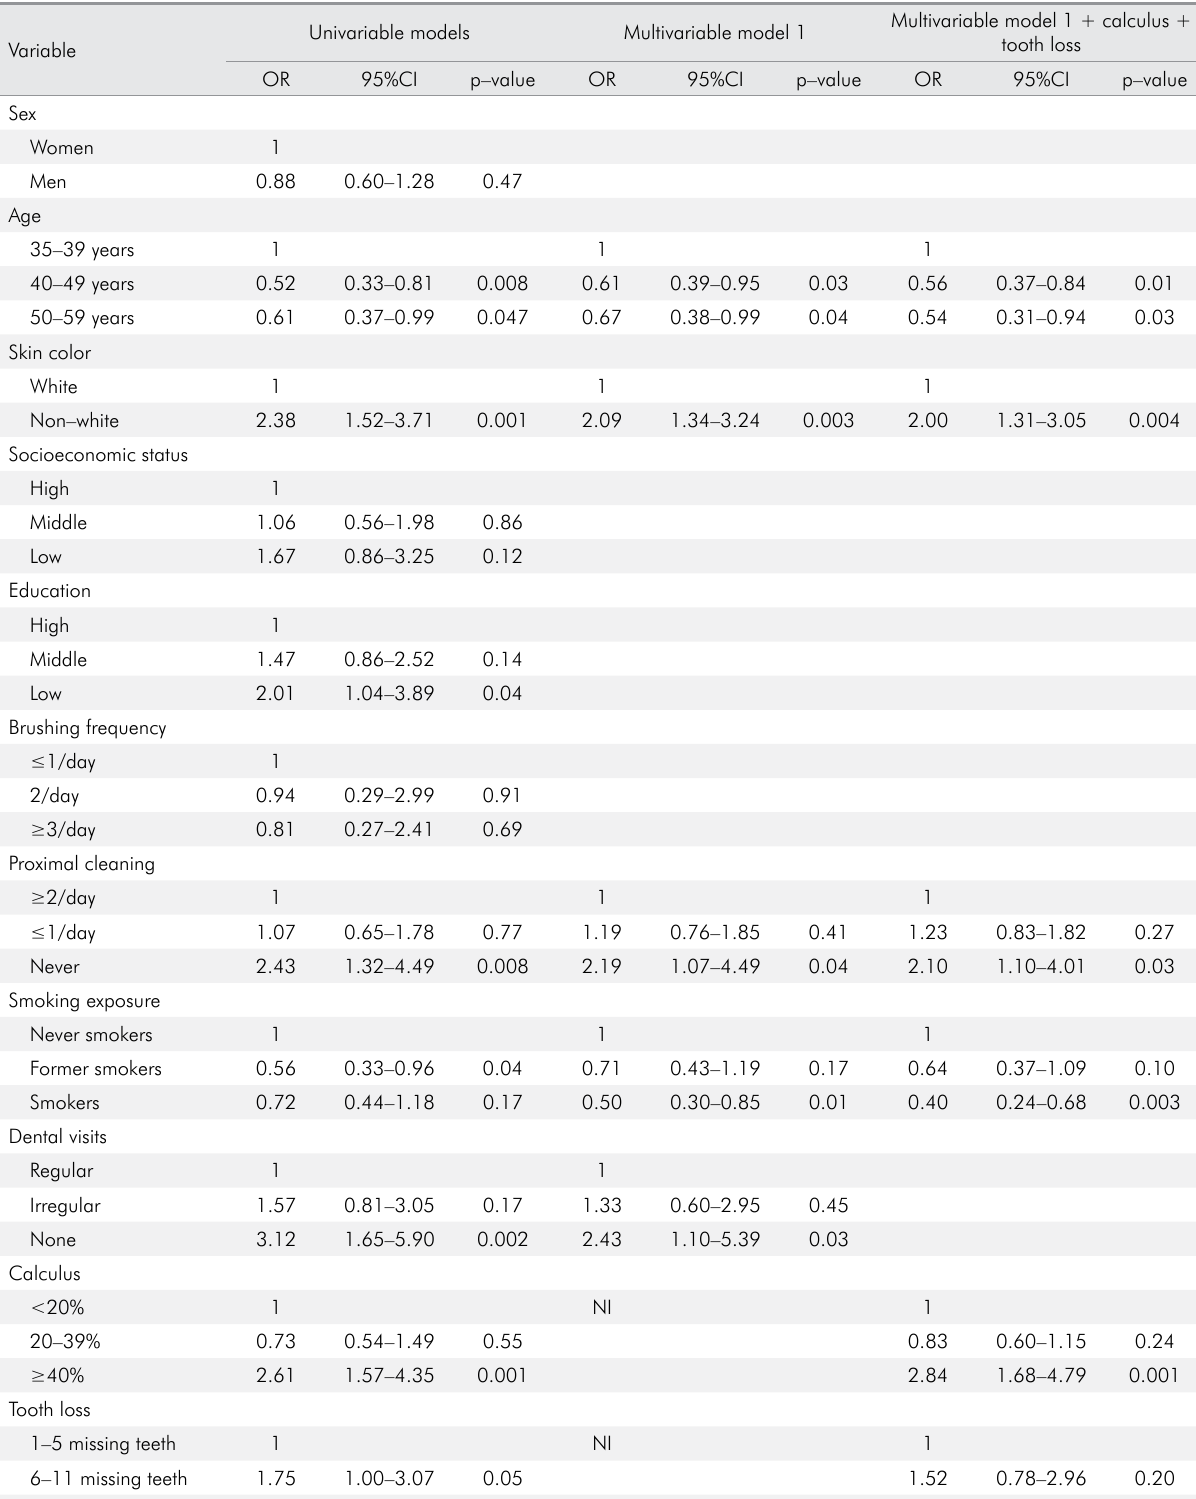
Table 2. Logistic regression models of the association between gingival bleeding index (>20%) and demographic, behavioral and clinical